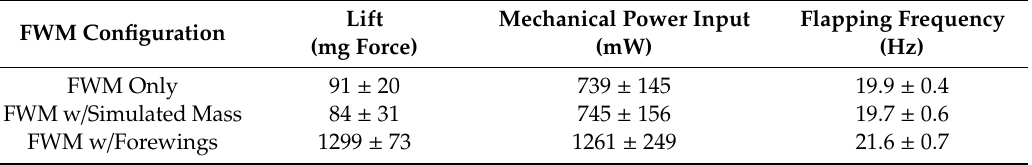
Table 4. System lift production results of FWM